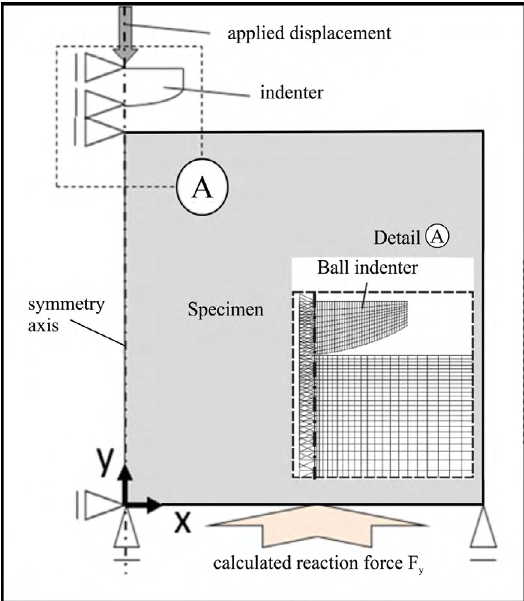
Figure 2. FEA simulation model of the ball indentation